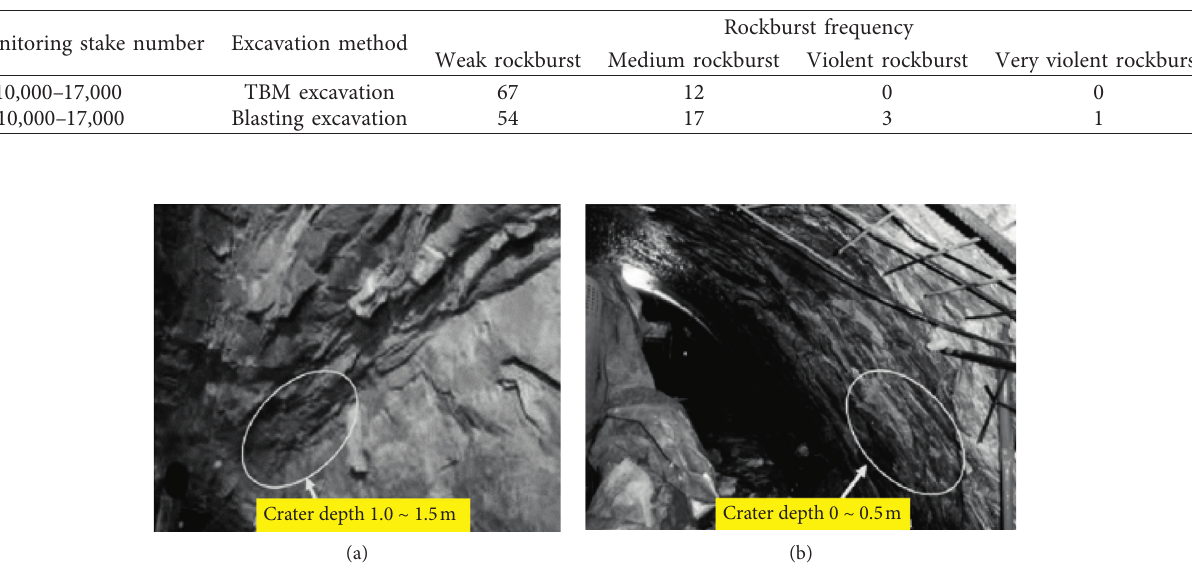
Table 6: Rockburst statistical results [62].